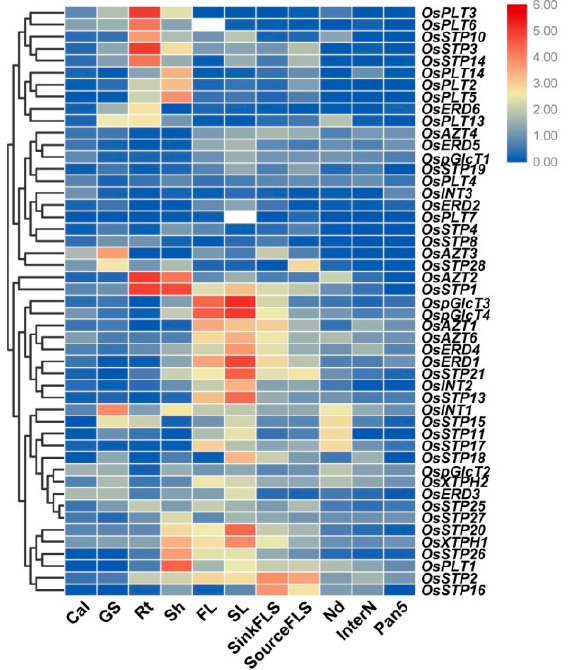
Figure 5. Expression profiles of the MST genes in 11 different tissues by qRT-PCR. Cal: calli